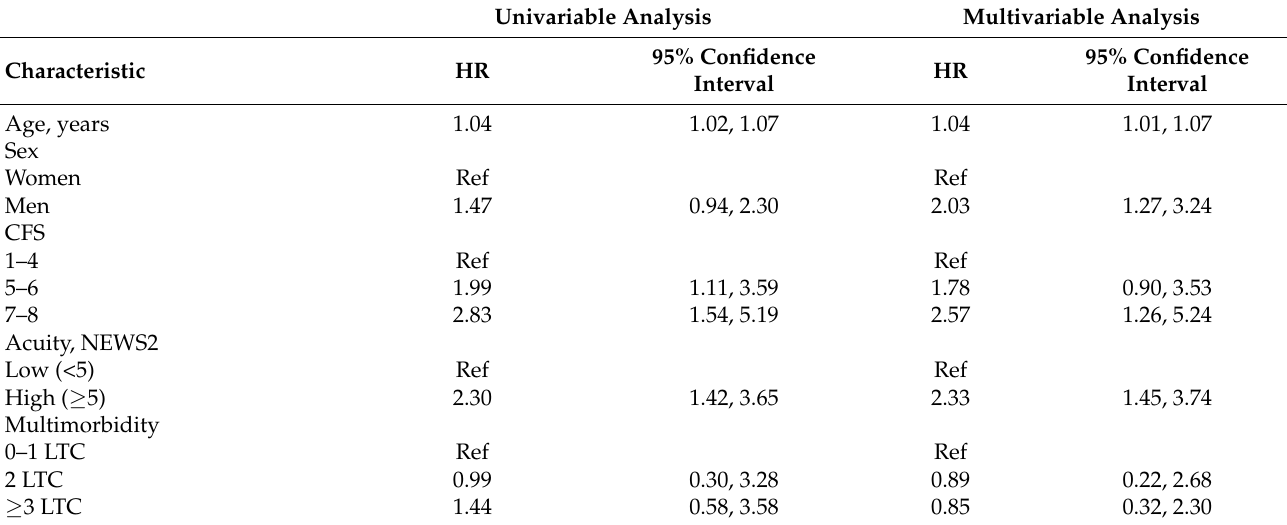
Table 3. Cox Proportional Hazards Regression Analysis: relationships between age, sex, frailty, illness acuity, multimorbidity and